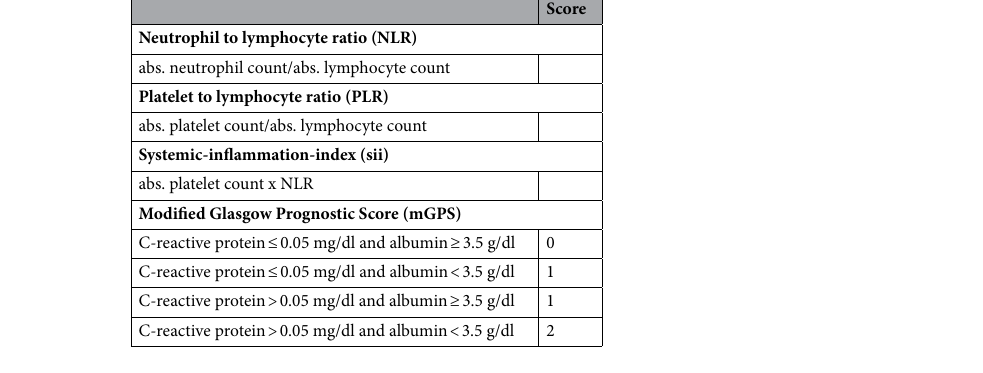
Table 1. Equations for inflammatory